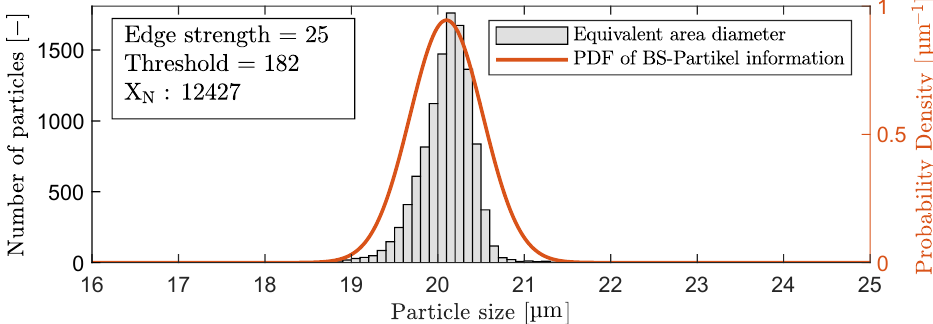
Figure 9. Included particles with a THV = 182 and a FRV = 25, measured by C 3 . Experiment